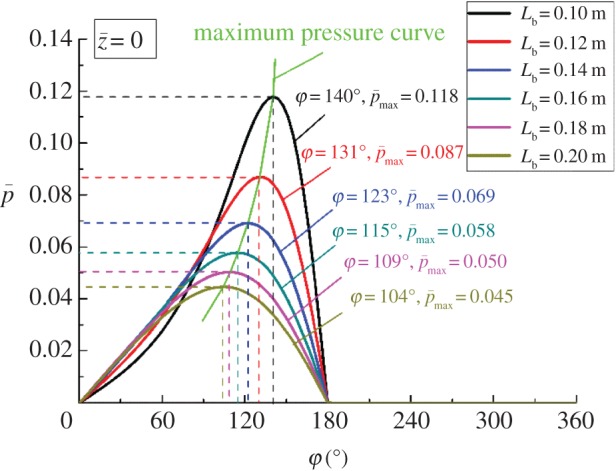
Pressure distribution with different Lb at z¯=0.